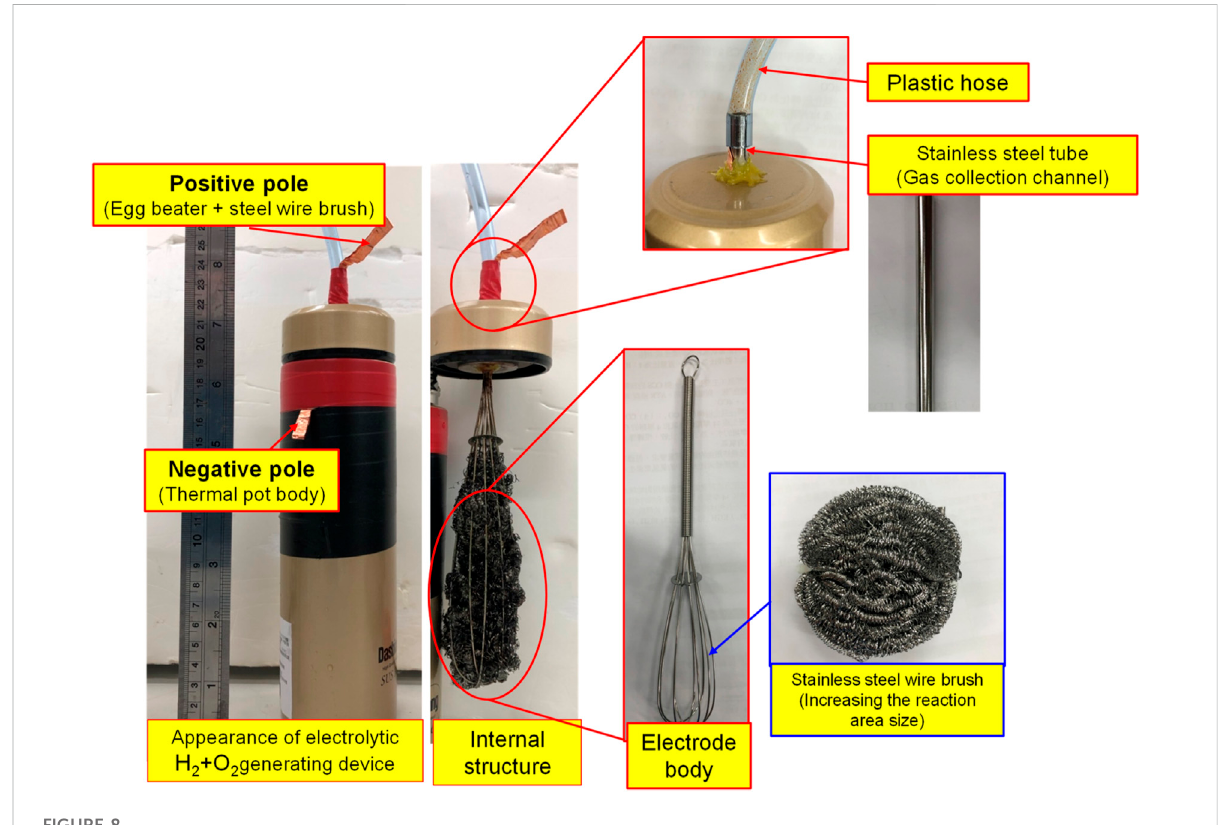
FIGURE 8 Water electrolysis H 2 +O 2 gas generating device physical